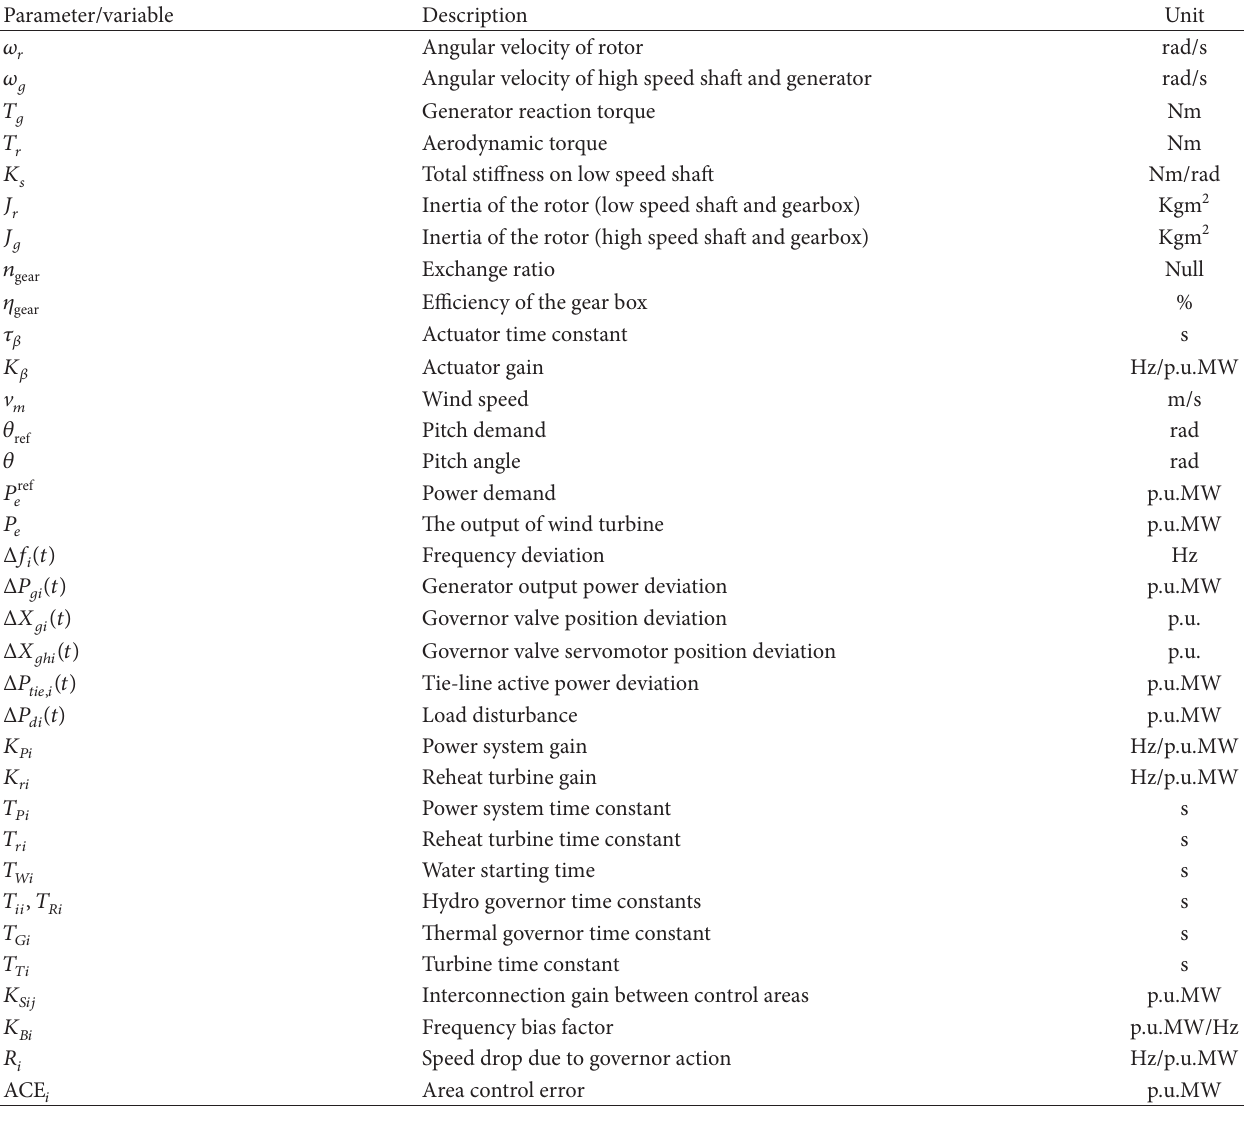
Table 1: Power system variables and parameter.